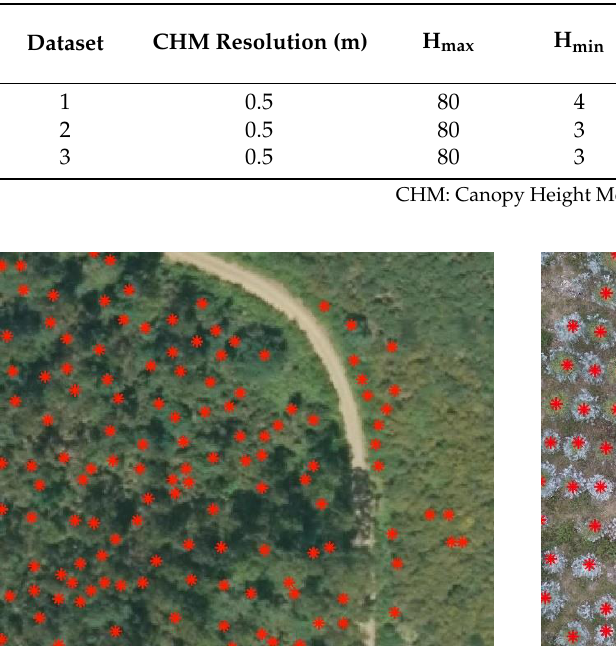
Figure 8. Results of the Variable-Sized Window (VSW) process for Dataset 2 ( a ) and Dataset 3 ( b ). Trees are represented by red dots. Table 5. Optimum configuration selected for each dataset for the watershed delineation algorithm.